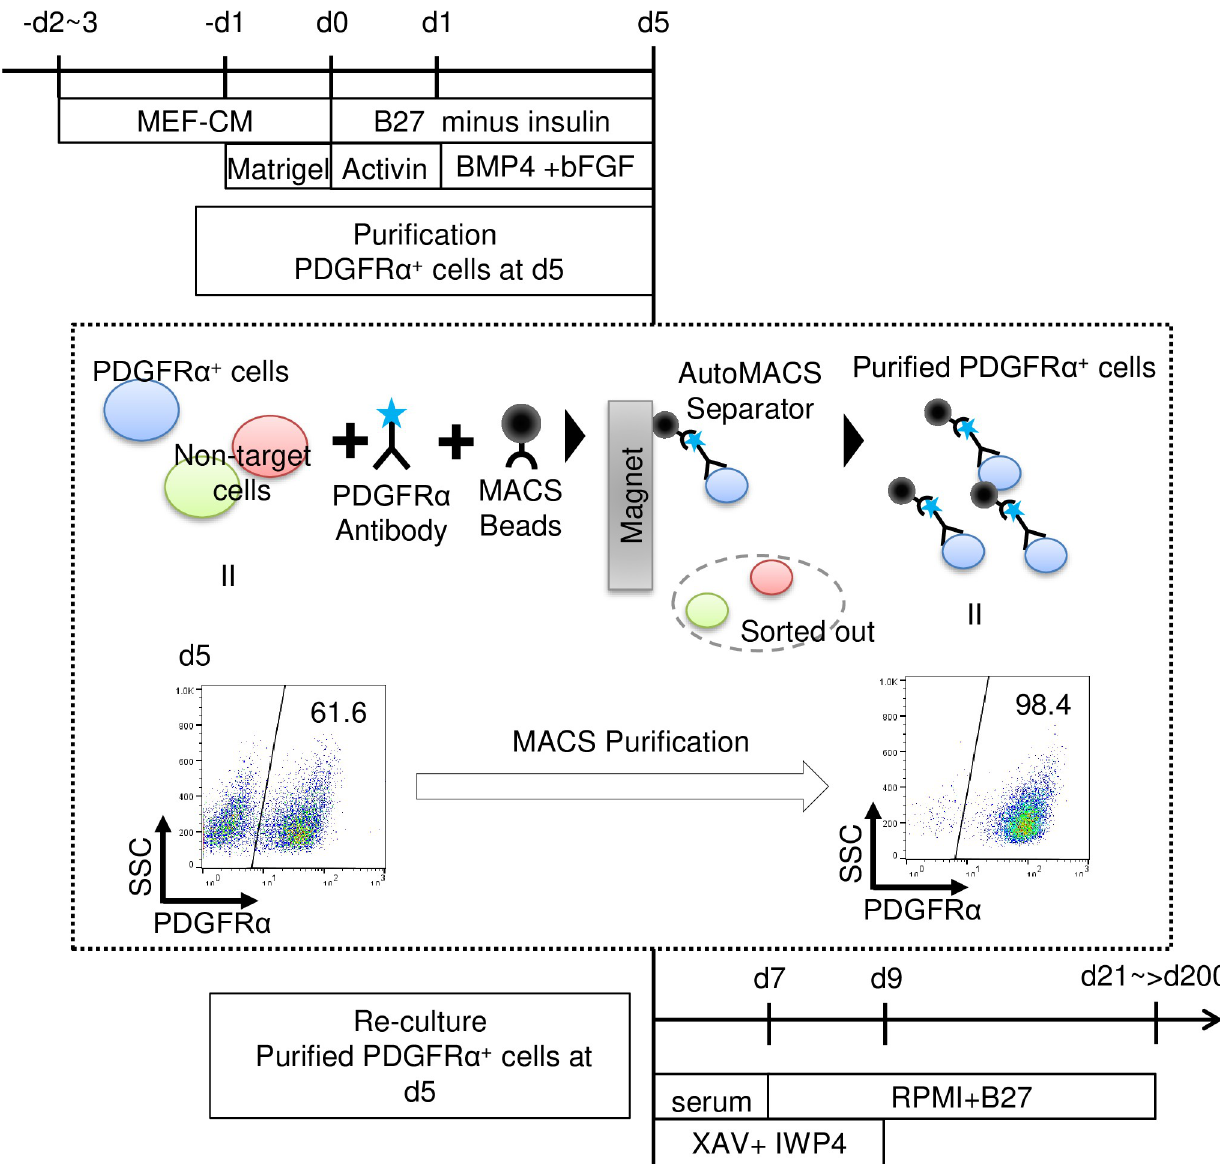
Fig 1. Scheme of optimized CM differentiation